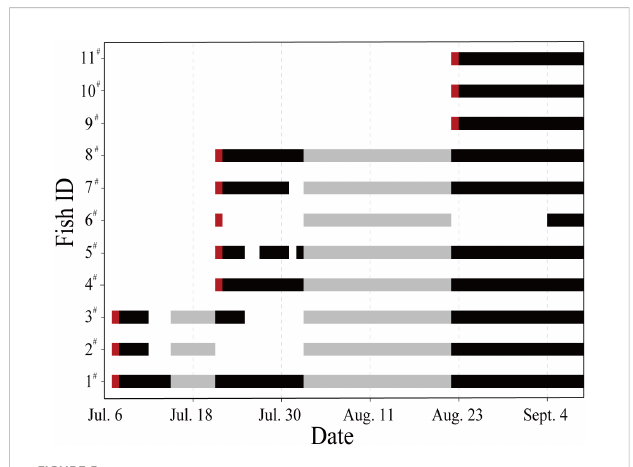
FIGURE 5 Plot of the daily presence – absence of 11 tagged reef fi sh between July and September 2017. Red represents the released date, black represents the detected date after the release, and gray represents the date without deploying the receiver